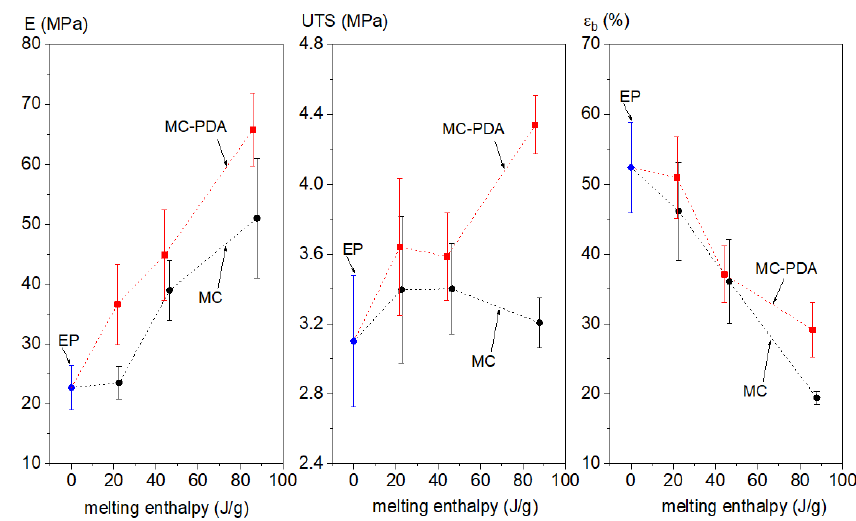
Figure 9. Elastic modulus ( E ), tensile strength ( UTS ), and strain at break ( ε b ) as a function of melting enthalpy of the prepared composites.